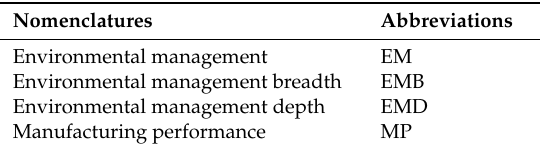
Table A1. Nomenclatures and abbreviations.